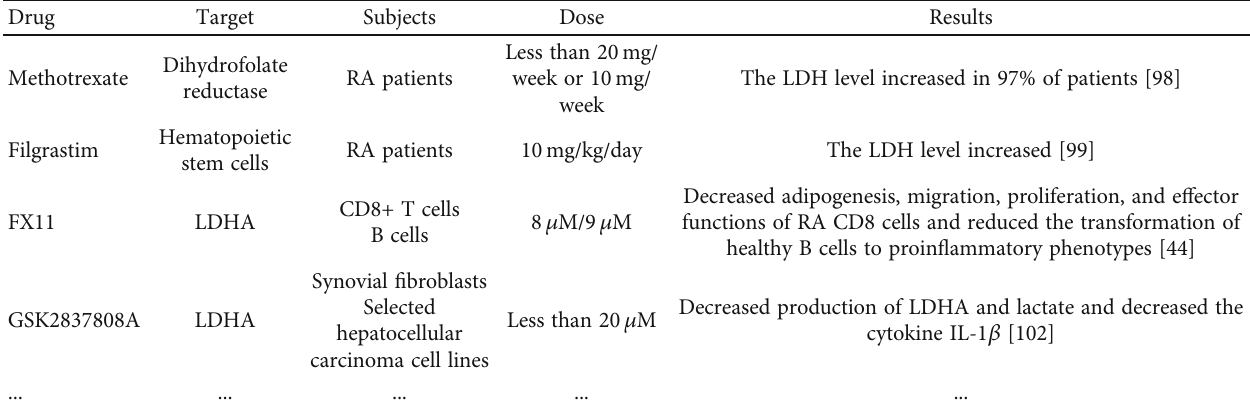
Table 2: Drugs that act on the production of lactic